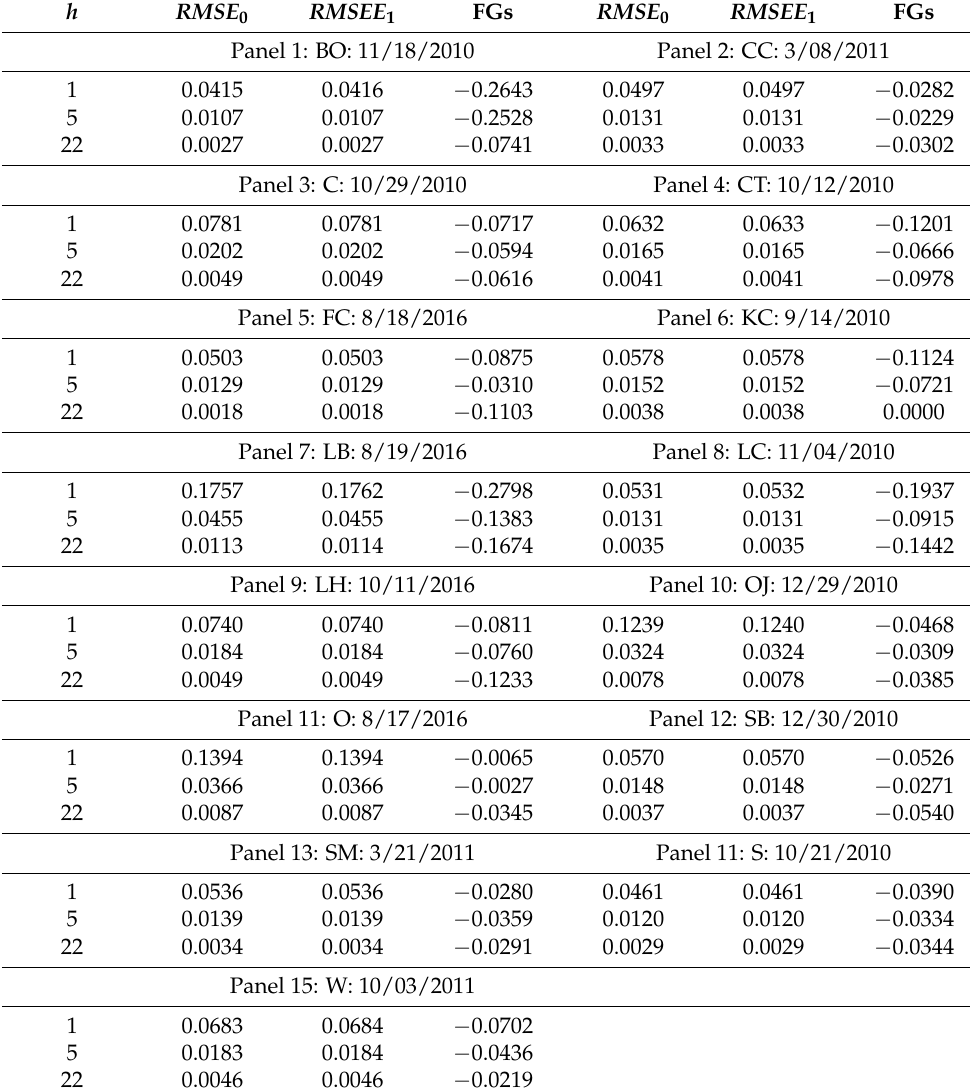
Table 2. Full out-of-sample forecasting